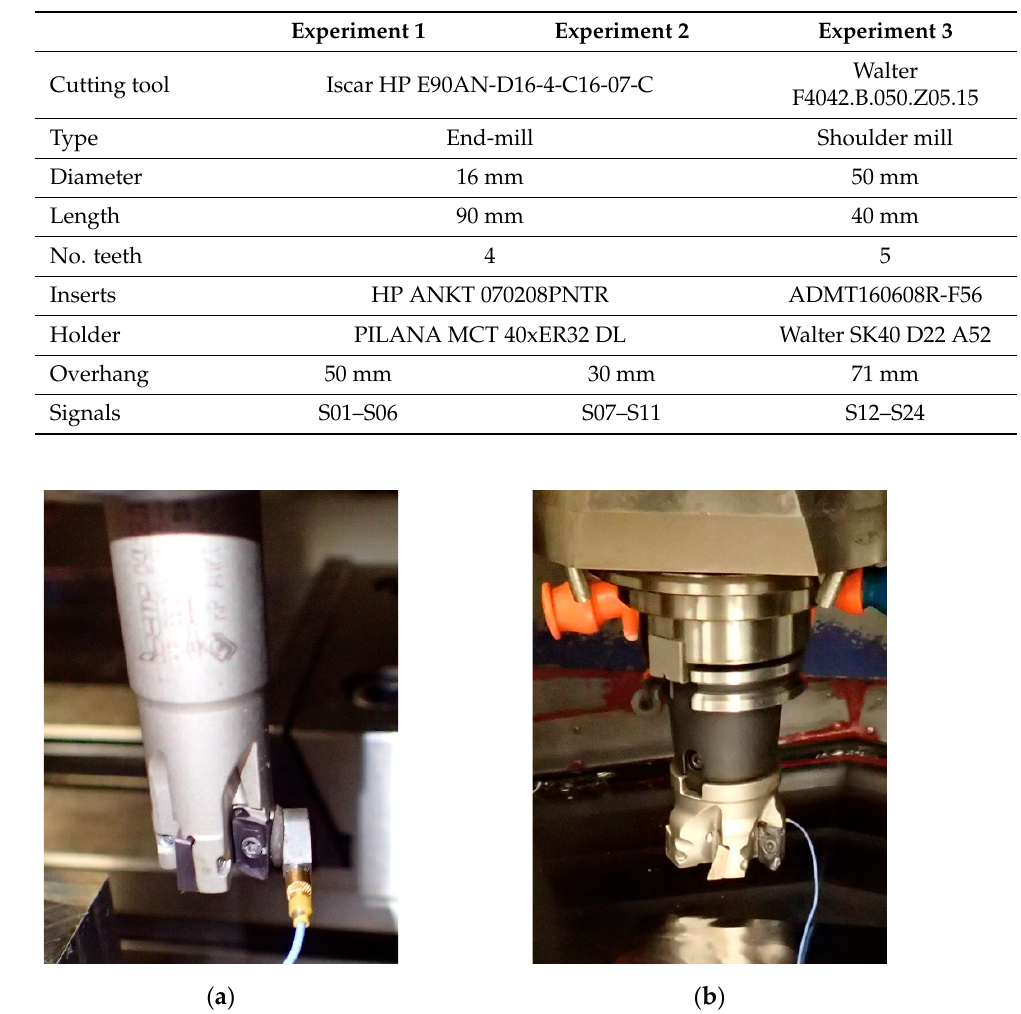
Figure 2. Cutting tools used for chatter identification: ( a ) Iscar E90AN, ( b ) Walter F4042.